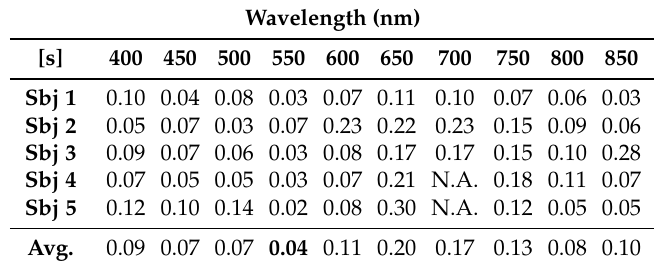
Table 3. Errors calculated as mean square error (MSE) between tachogram obtained from ECG track and SPAD pulse signals. Bold values represent best results.